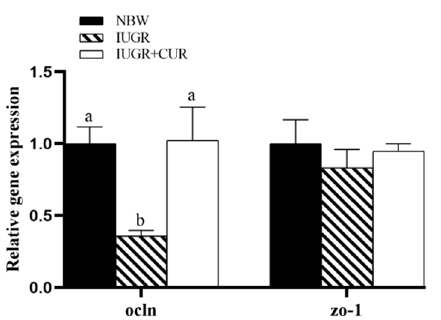
Figure 5. E ff ects of curcumin on occludin ( ocln ) and tight junction protein 1 ( ZO-1 ) gene expression in